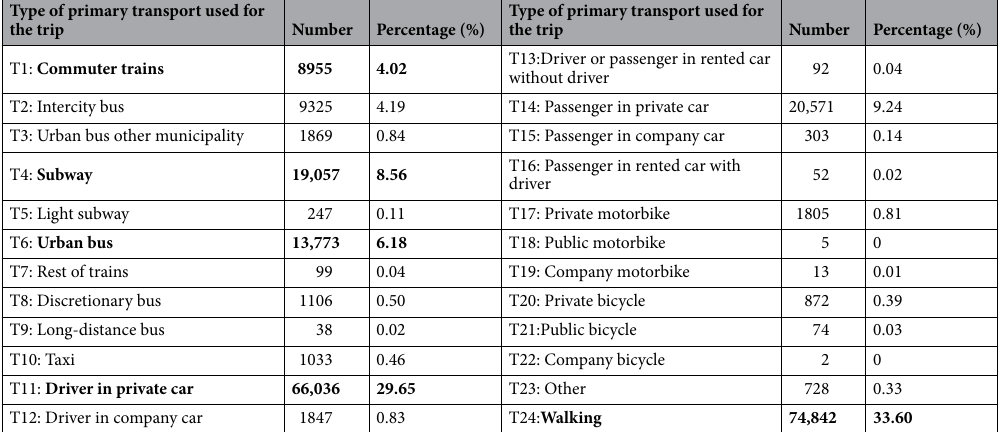
Type of primary transport used for the